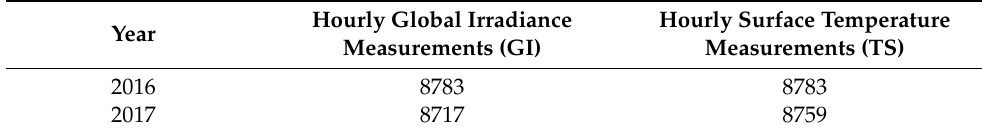
Table 8. Number of available mutual hourly measurements in both datasets for years 2016 and 2017 in Bremen.